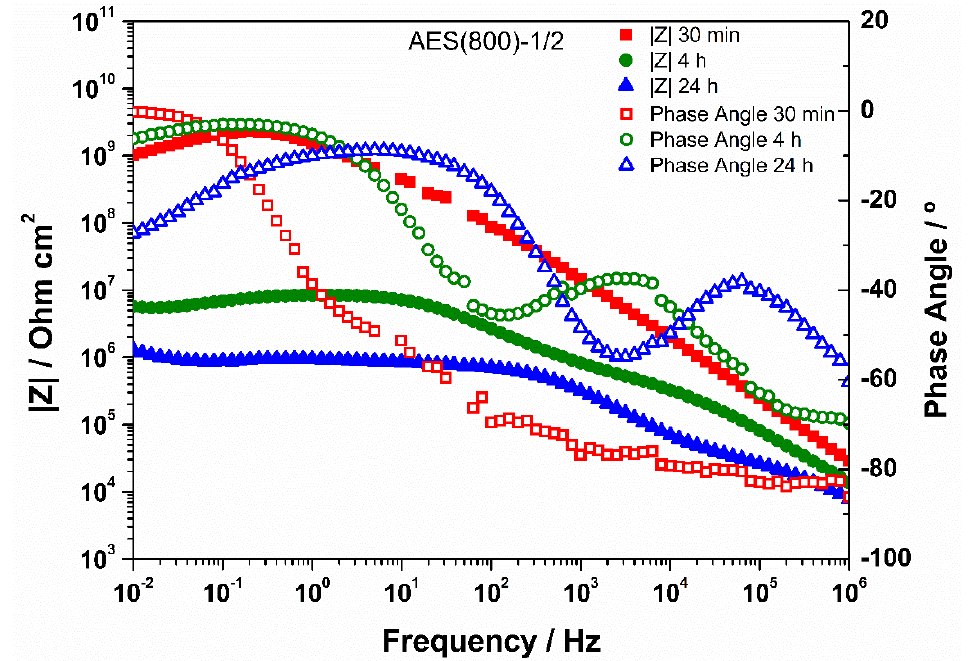
Figure 9. Bode plot for EIS analysis of AES(800)-1 / 2 after 30 min, 4 h and 24 h in SCPS.